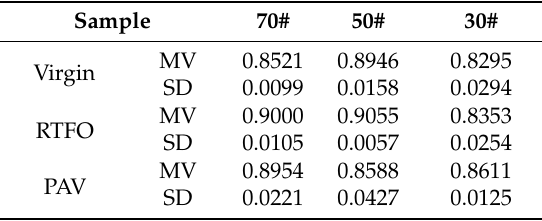
Table 3. Mean value (MV) and standard deviation (SD) of the DMT modulus.